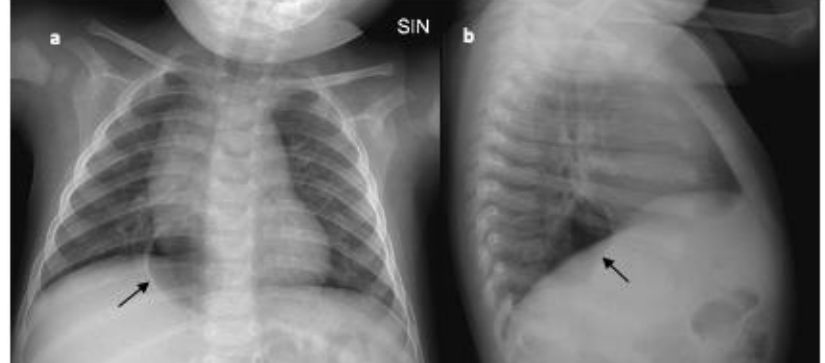
Figure 3. ( a ) Anteroposterior (AP) and ( b ) lateral (L) view of chest X-ray made at 6 months of follow up; the black arrow indicates the unchanged air collection in the posterior mediastinum.